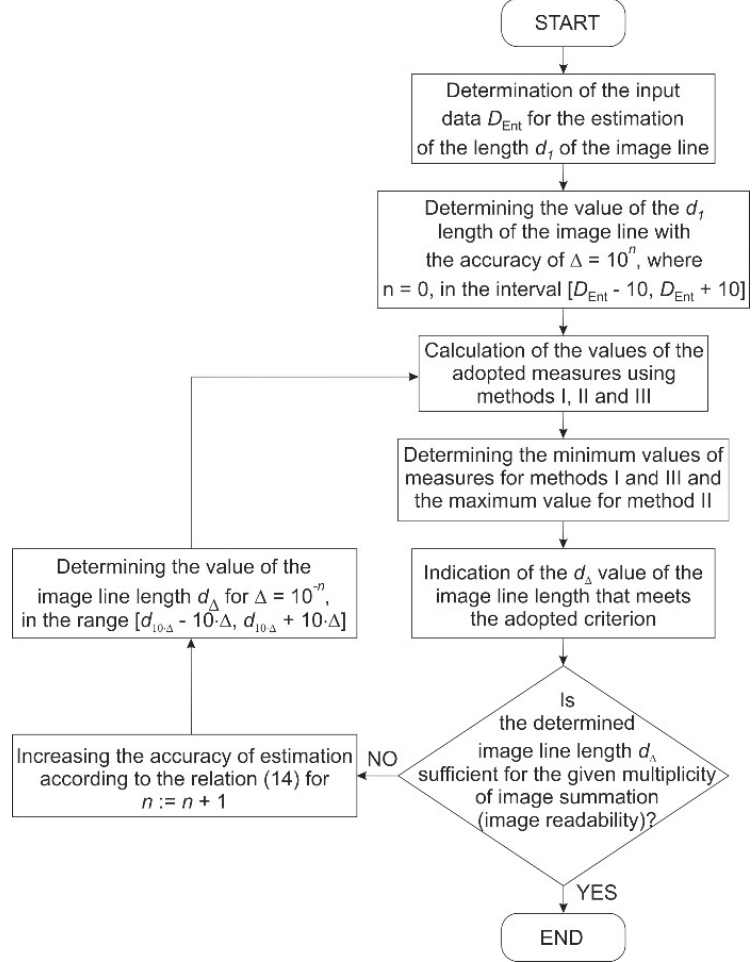
Figure 9. Algorithm of the determining the correct line length 𝑑